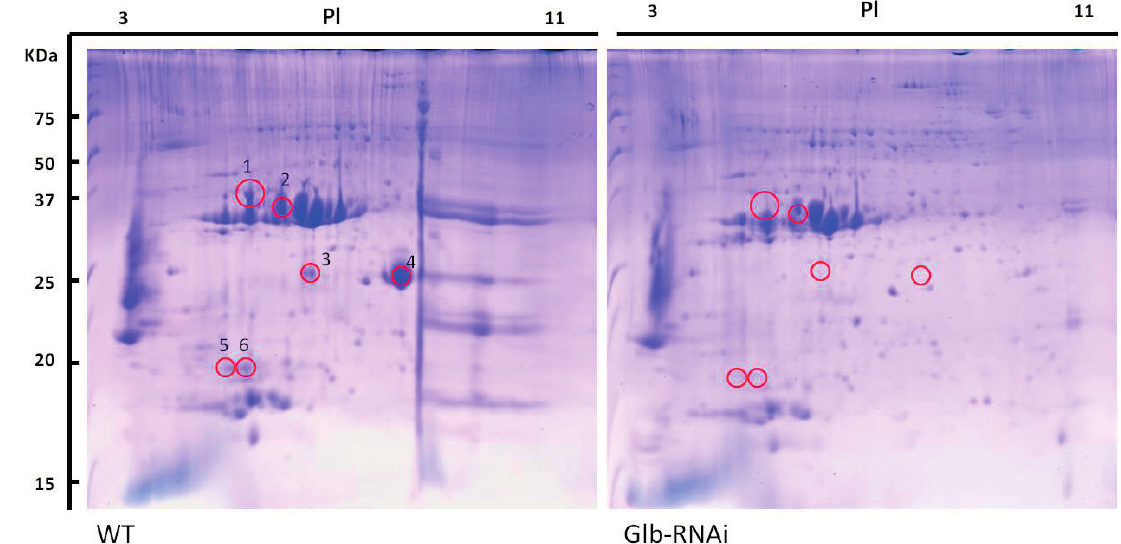
Figure 5. Isoelectric focusing and SDS-PAGE analyses of wild type (WT) and Glb-RNAi seeds. Equal amounts (20 mg) of seed powder from WT and Glb-RNAi transformant seeds were resolved in SDS-urea buffer and the total proteins were separated with 2-DE, as described in the Methods. The intensities of the labeled protein spots (shown inside the red circles) were lower in the protein extract from the transformants compared with those from WT extract. The CBB-stained 2-D gels were photographed and the images were analyzed with ImageJ. PI, isoelectric